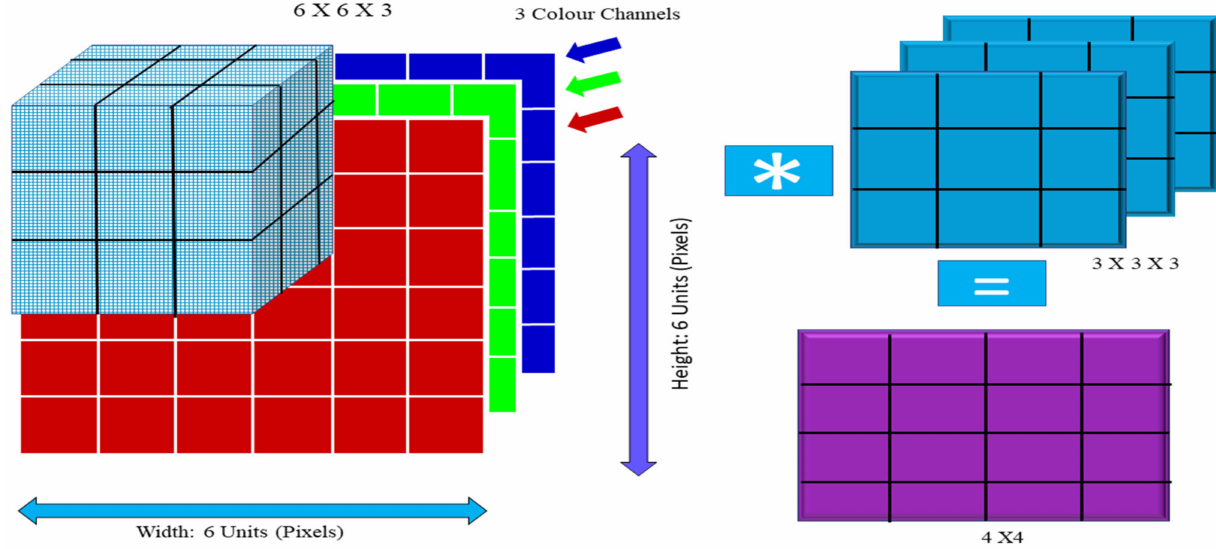
Figure 5. Filter matrix of the convolution